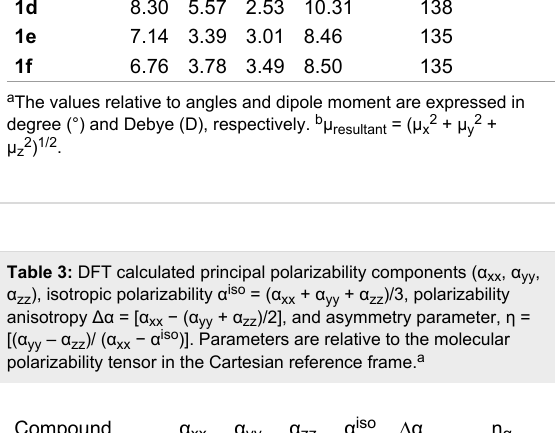
The three dihedral angles between the first phenyl and central phenyl moieties with imine linkage, central ring and first biphenyl ring with ester linkage and between the two phenyl rings of biphenyl moiety are 142°, 138° and 143°, respectively (Figure 3), reflecting the absence of coplanarity of the phenyl rings in the molecule. The analysis shows that the bend angle is approximately 143° for all mesogens and is influenced by the transverse chloro substituent in the 2-position of the central phenyl ring. The bending angle for the compound 1d is 138° and for 1e and 1f is 135°. This may have contributed to an increase in intermolecular separation and thereby did not promote mesomorphism. For all the mesogens, the dipole points almost in the lateral direction with respect to molecular long axis.